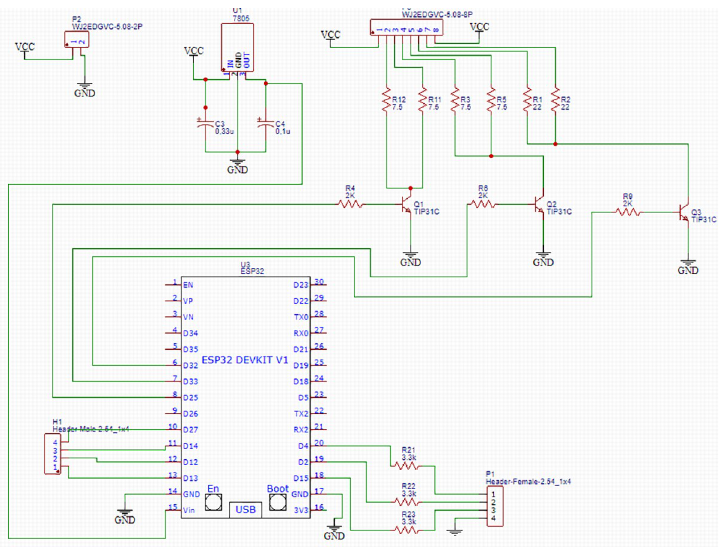
Fig 2. Diagram representing the system’s electric circuit, describing the component dimensioning and best arrangement, as well as the respective microcontroller inputs and outputs.